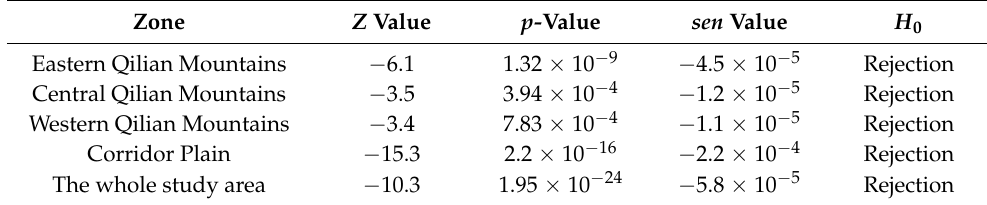
Table 2. Result of the Mann-Kendall test.